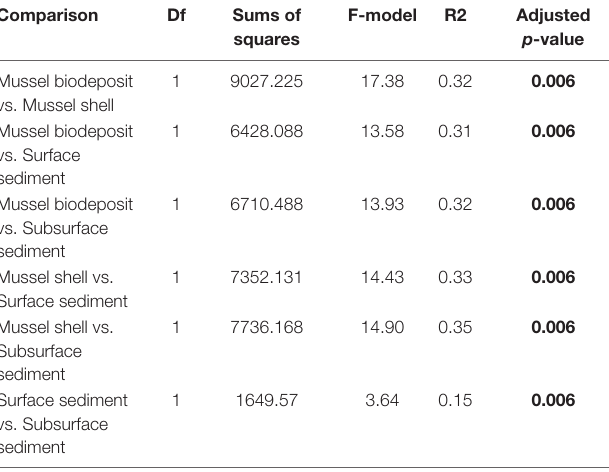
Comparison Df Sums of